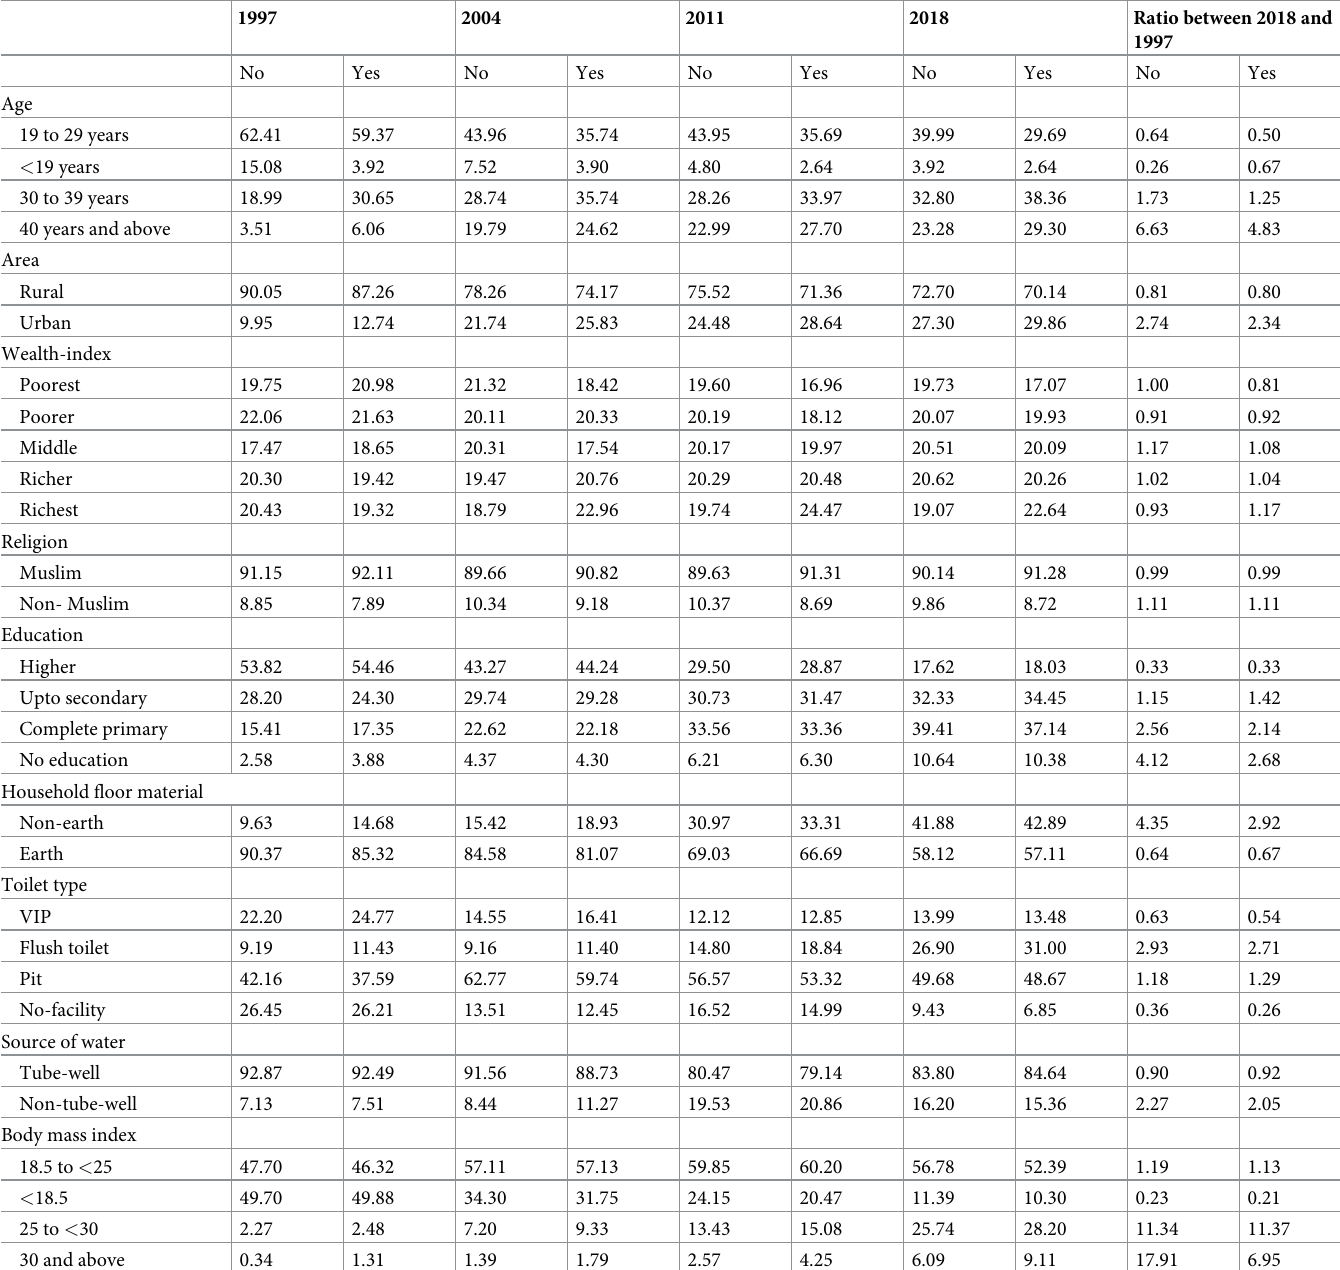
Table 1. Proportion (weighted) 1 of different factors by fatal pregnancy termination in four survey time